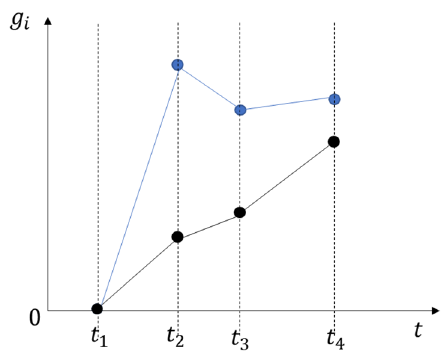
Figure 1. The idea of the area model in graphic form. Source: own